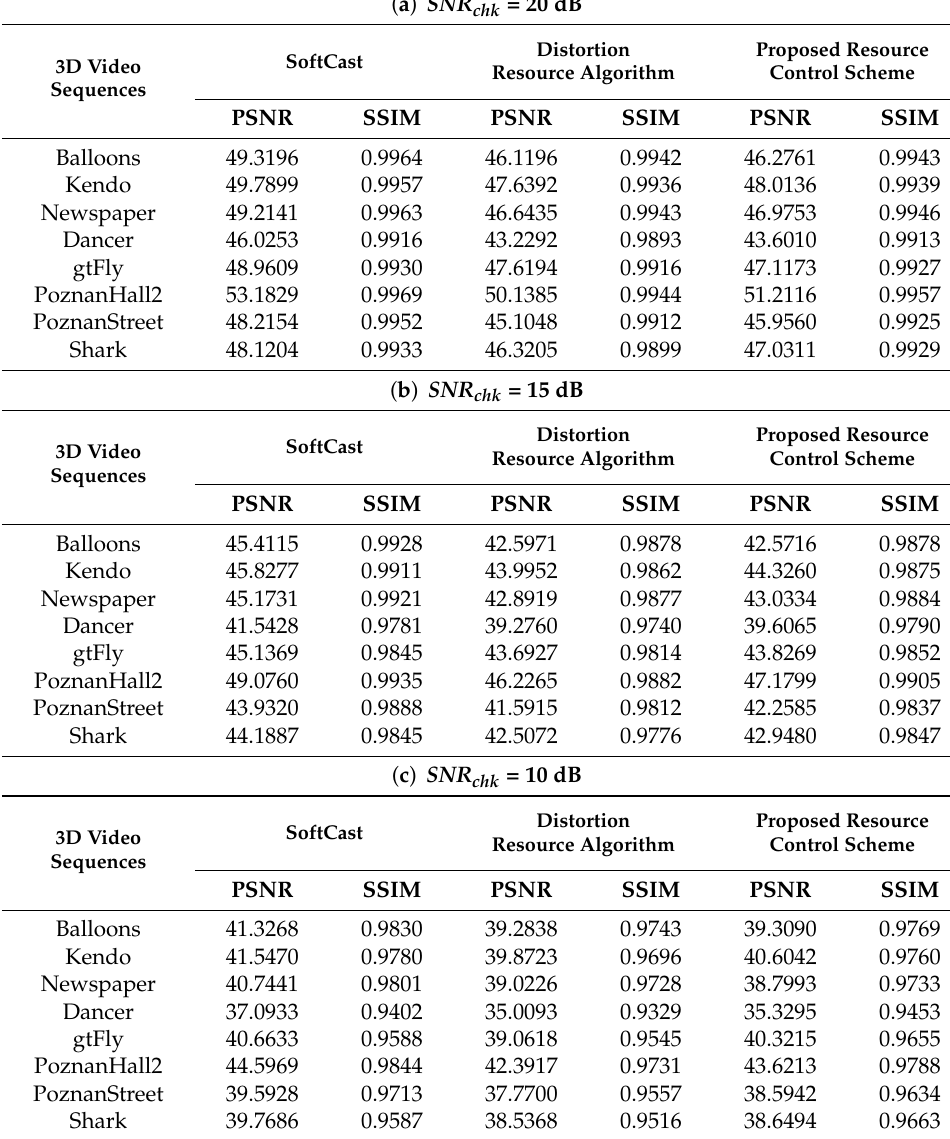
Table 4. Preformance comparison for different 3D video